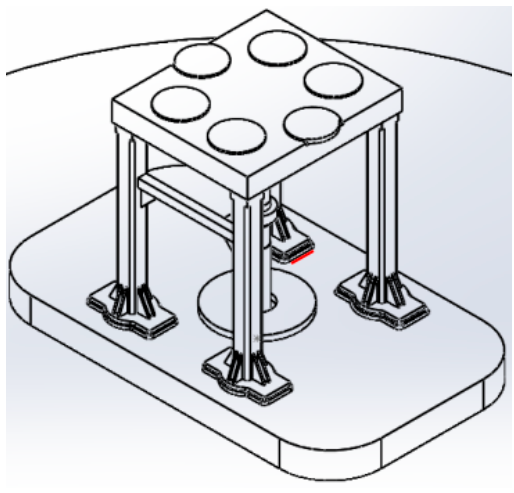
Figure 3. Schematic diagram of the weld cracking position.